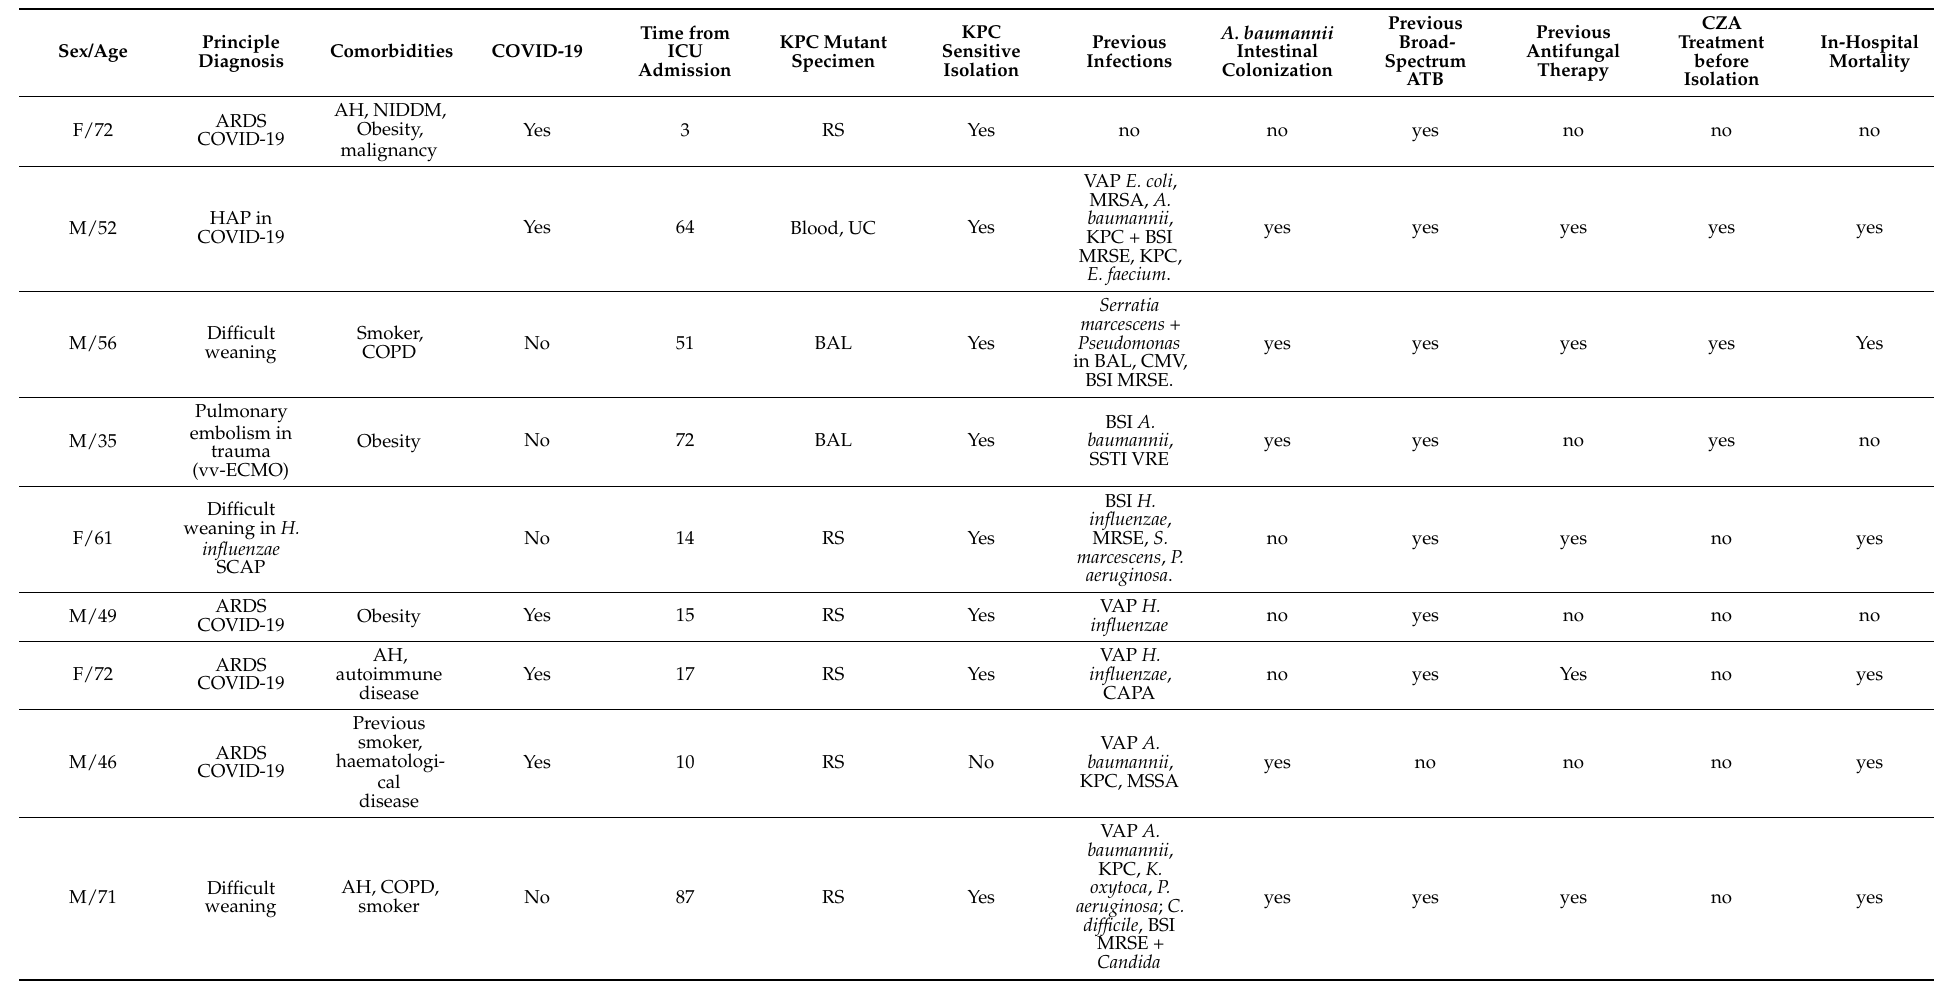
Table 2. Clinical characteristics of patients with mutant